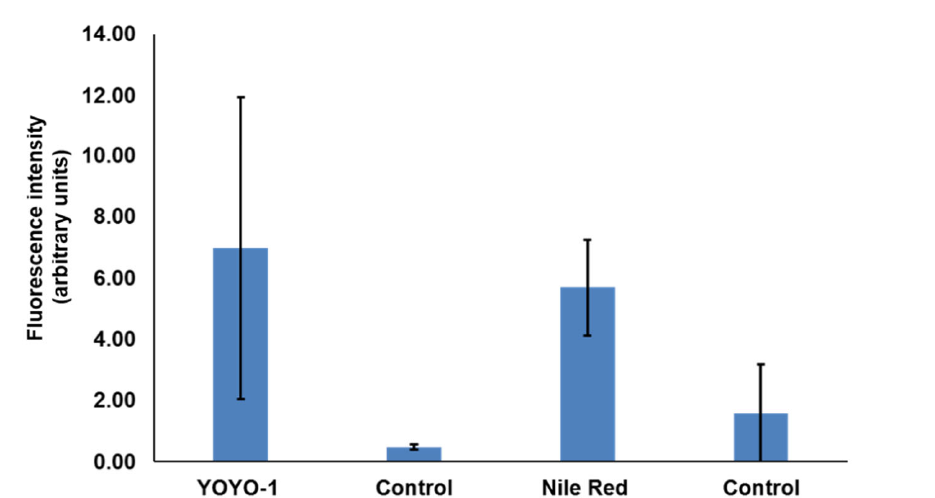
Figure 10. CLSM images acquired using Leica SP8 at 63 × of P. atlantica EPS MGP model stained for eDNA with YOYO-1 (green); Nile red (red) as counter stain for bacterial cell walls to localise the presence of eDNA. Scale bar = 5 µ m ( A ). Quantification of the fluorescence intensity of each fluorophore revealed high mean value of YOYO-1, indicating the presence of eDNA. The control is unstained particles. The graphs present the mean ± SD of 15 CLSM micrographs. Error bars represent the standard deviation of the data set ( n = 3), p < 0.05 ( B ).